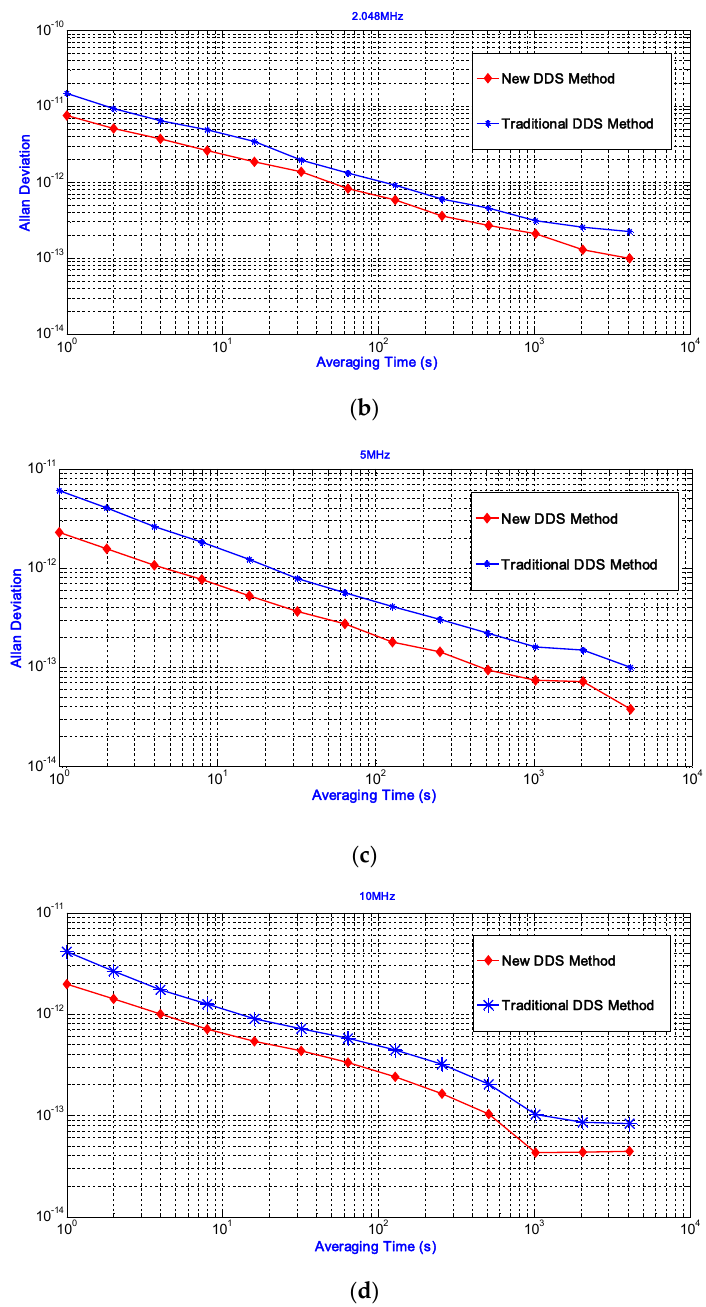
Figure 9. Stability of different frequency points. ( a ) Stability of 1.024 MHz; ( b ) Stability of 2.048 MHz; ( c ) Stability of 5 MHz; ( d ) Stability of 10 MHz .